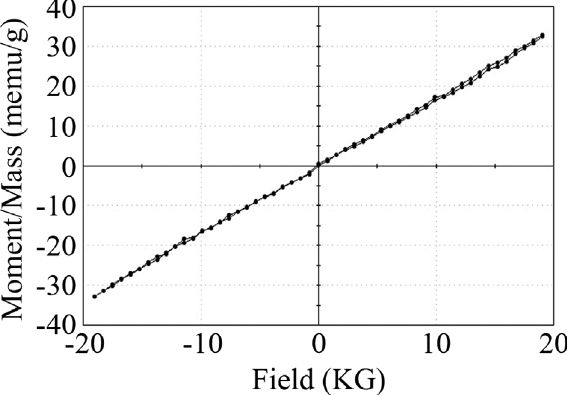
Figure 6: Magnetization curve of the prepared INPs, magnetization value of the synthesized INPs was measured to be 33 memu/g.